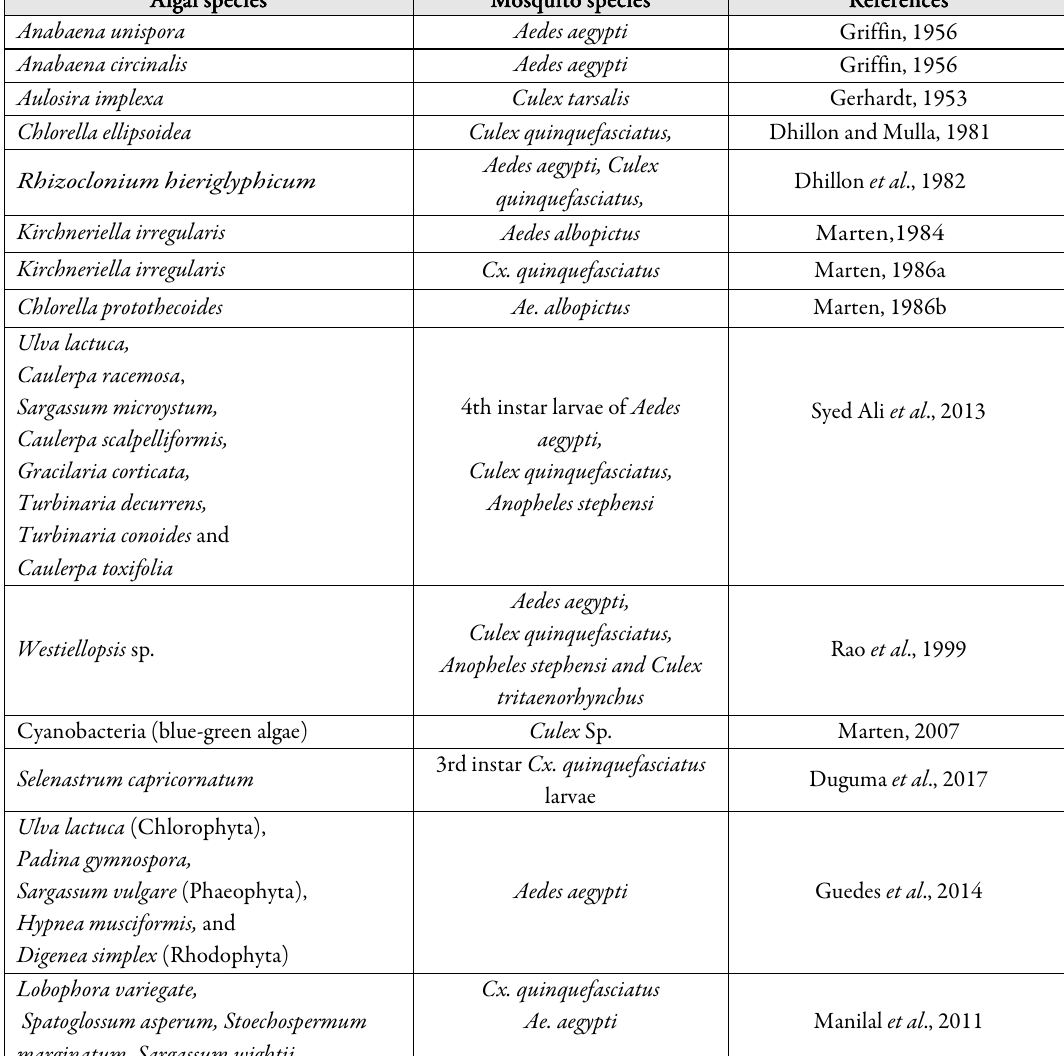
Table 4. List of algal species reported as mosquito